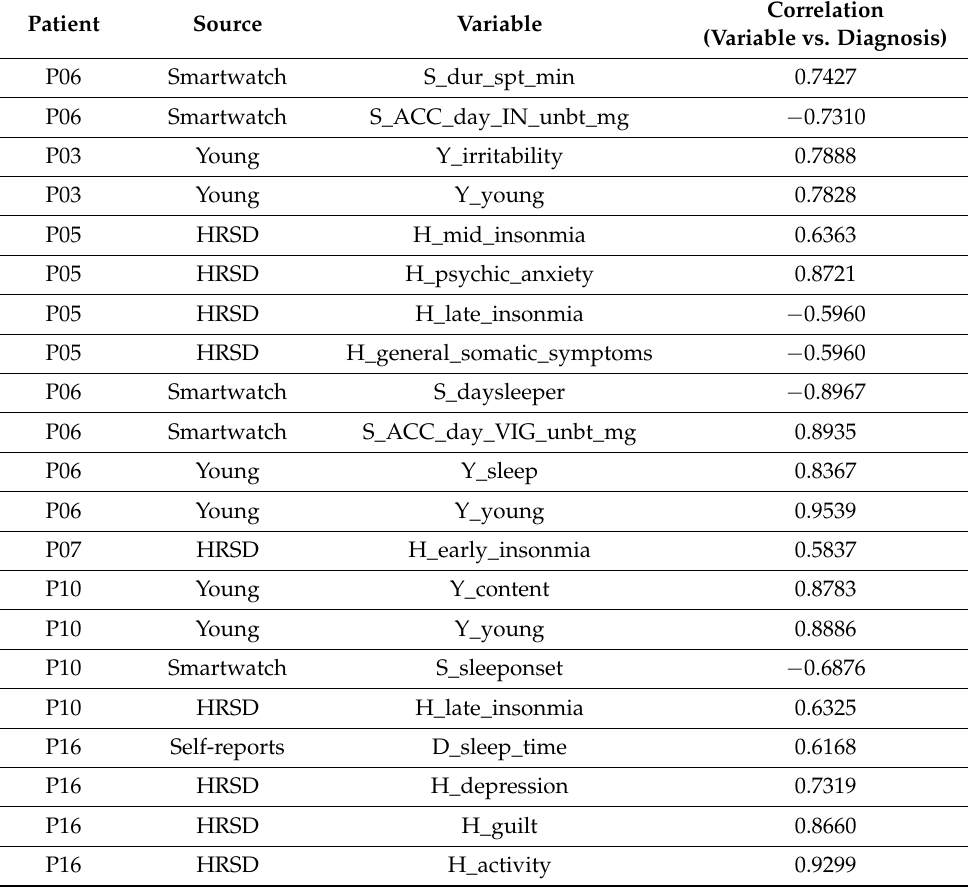
Table 5. Variables with the highest correlation with variable diagnosis for some patients. Patient Source Variable